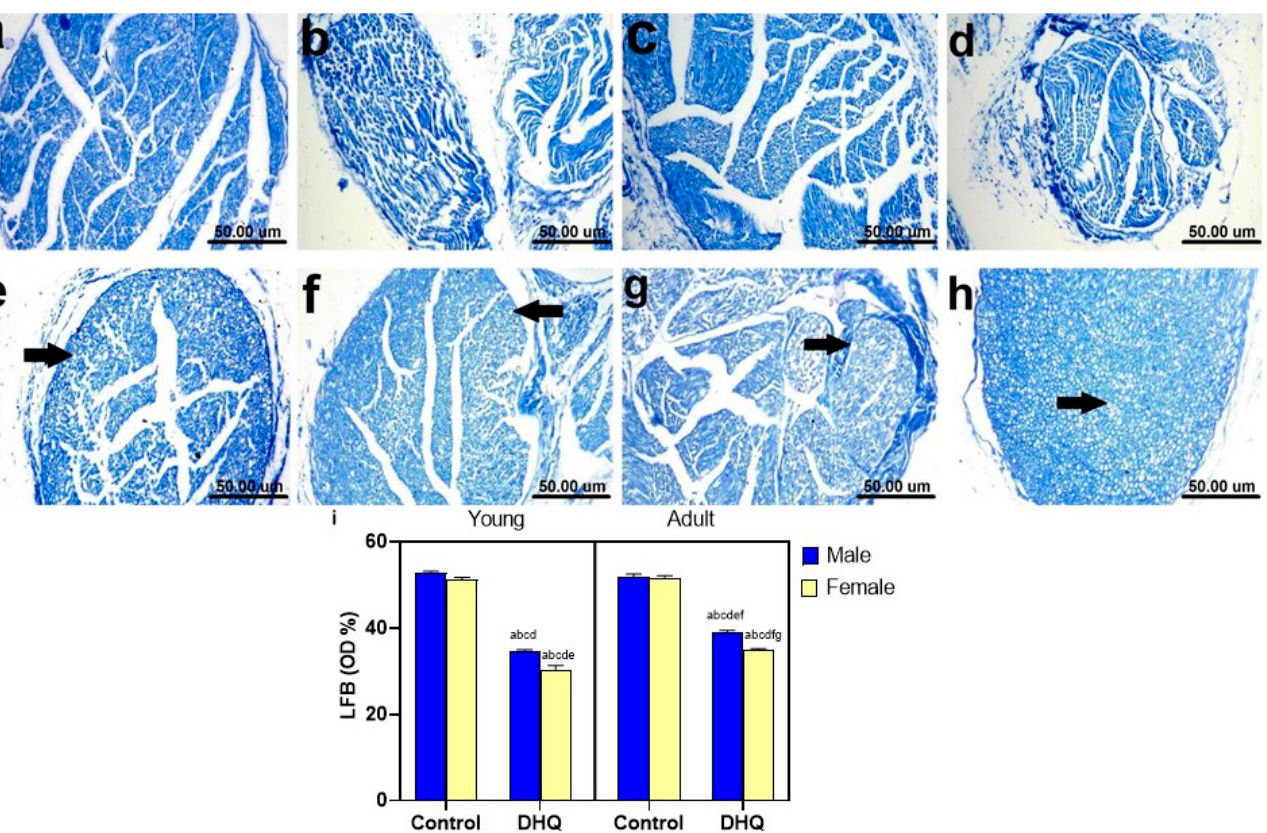
dark blue myelinated axons. ( e – h ) showing demyelination in white and gray matter (black arrow), ( e ) DHQ young male, ( f ) DHQ young female, ( g ) DHQ adult male, and ( h ) DHQ adult female. (Scale bar 50 um). ( i ) Quantitative analysis of LFB staining in sections from spinal cords. Each bar with a vertical line represents the mean ± S.D. of 5 rats per group (5 fields/rat). a vs. control young male, b vs. control young female, c vs. control adult male, d vs. control adult female, e vs. DHQ young male, f vs. DHQ young female, and g vs. DHQ adult male using three-way ANOVA followed by Tukey’s post hoc test; p < 0.05. DHQ; diiodohydroxyquinoline.